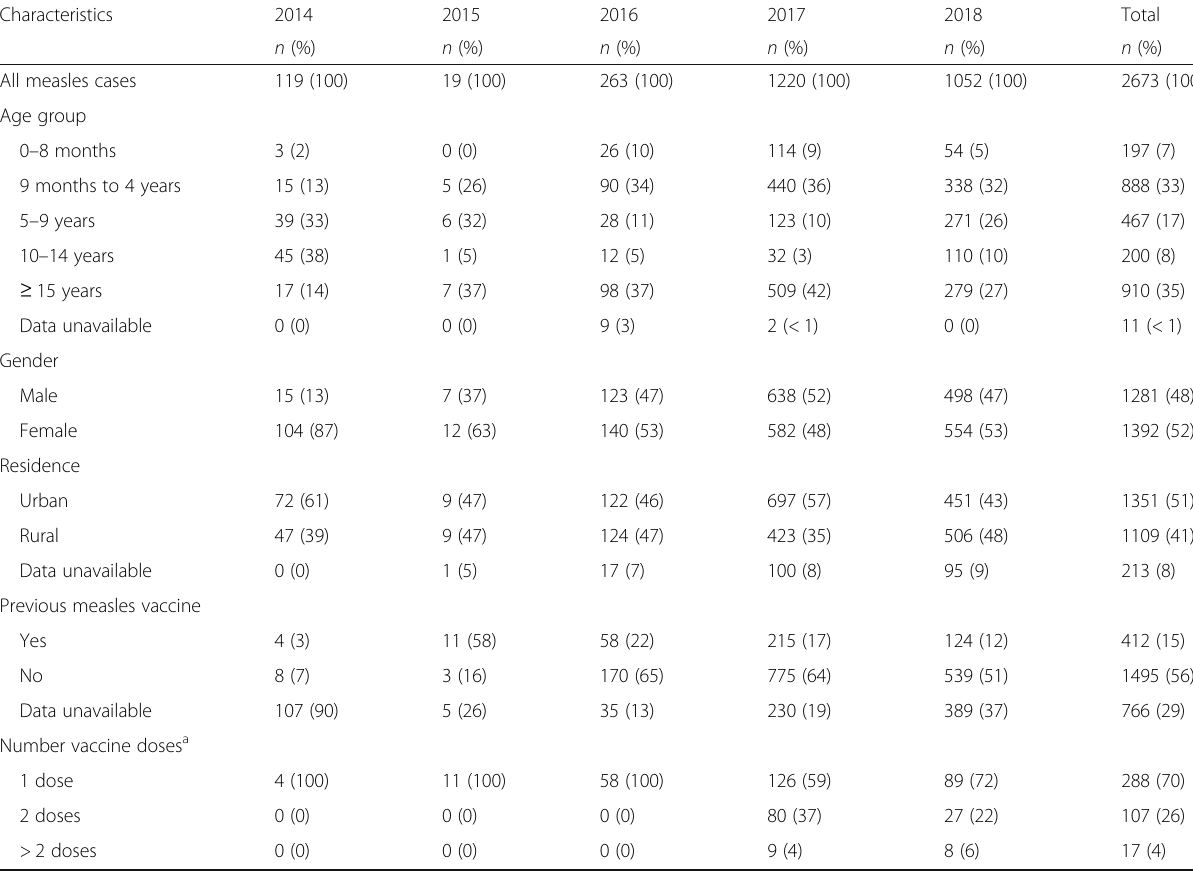
Table 2 Demographic and vaccination characteristics of annual reported measles cases in Myanmar: 2014 – 2018